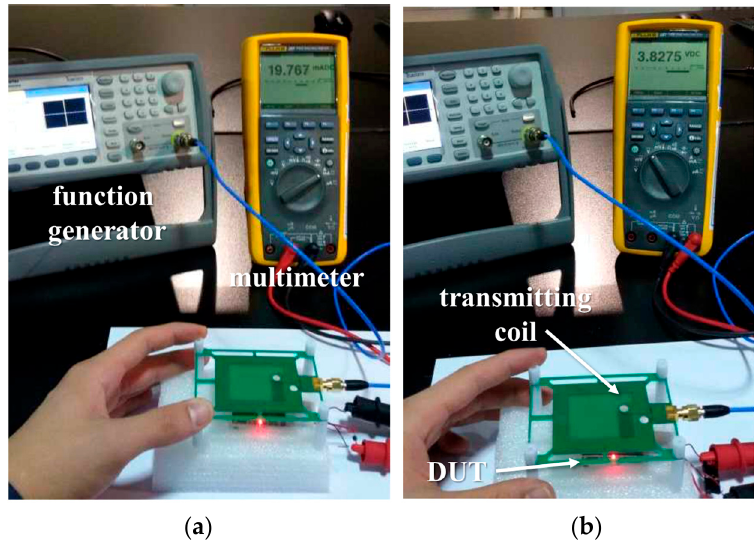
Figure 16. Wireless charging test in pork at distances of ( a ) 1 and ( b ) 2 cm.